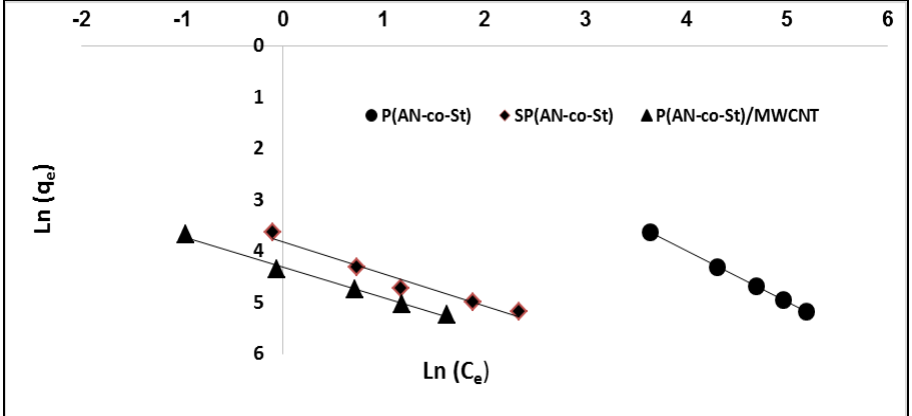
Figure 12. Temkin plots for adsorption of MO onto different composites.